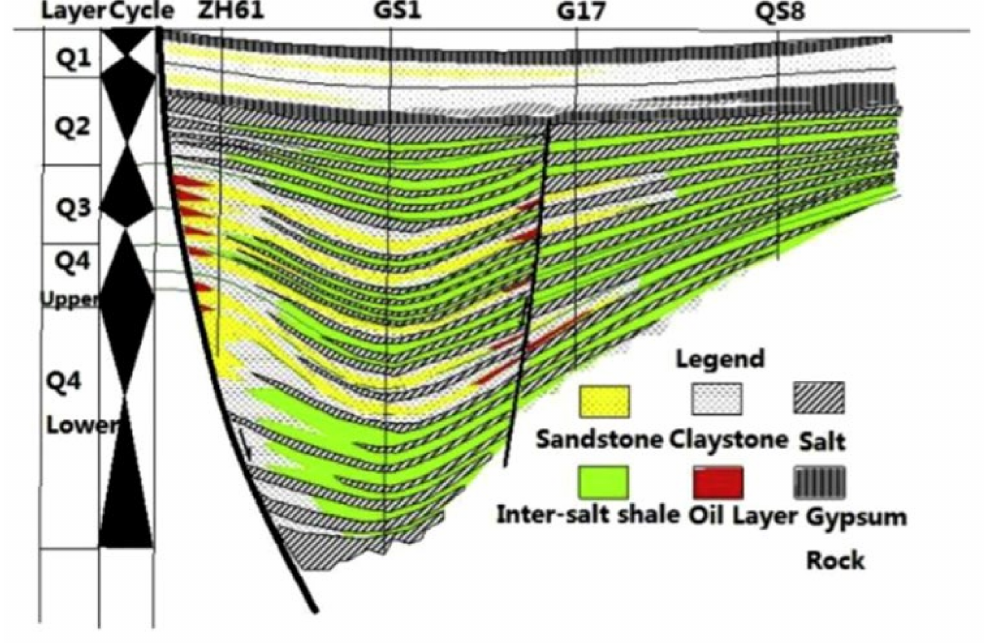
Figure 1. Stratigraphic sequence of the Qianjiang Formation